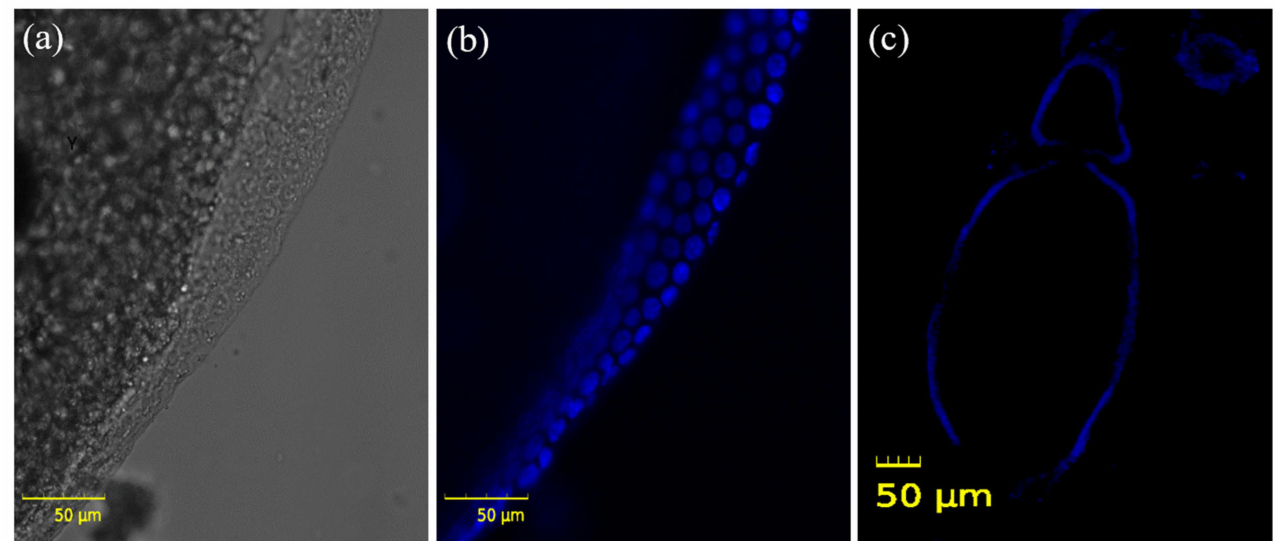
Figure 4. Identification of ovarioles from a female adult mealworm using frozen sections. ( a ) The yolk globule is in the ovariole, and ( b ) is surrounded by follicular epithelium. ( c ) The structure of the ovarioles was confirmed through DAPI staining.